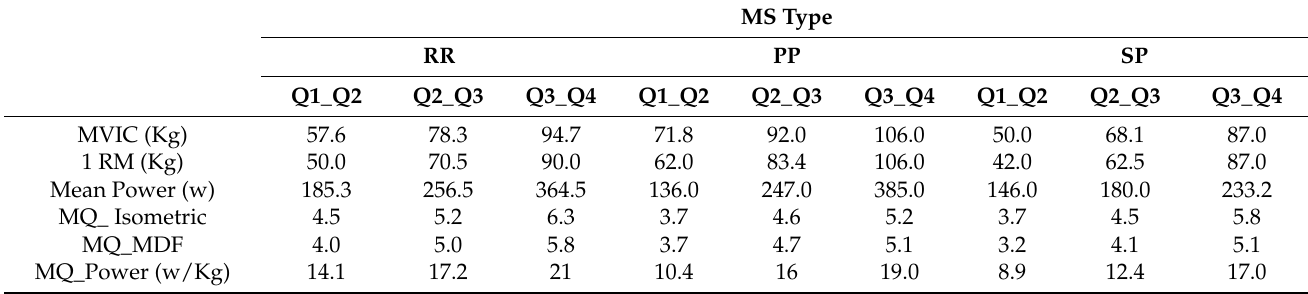
Table 7. Cut-off points for quartiles of the variables according to the type of MS. MS Type